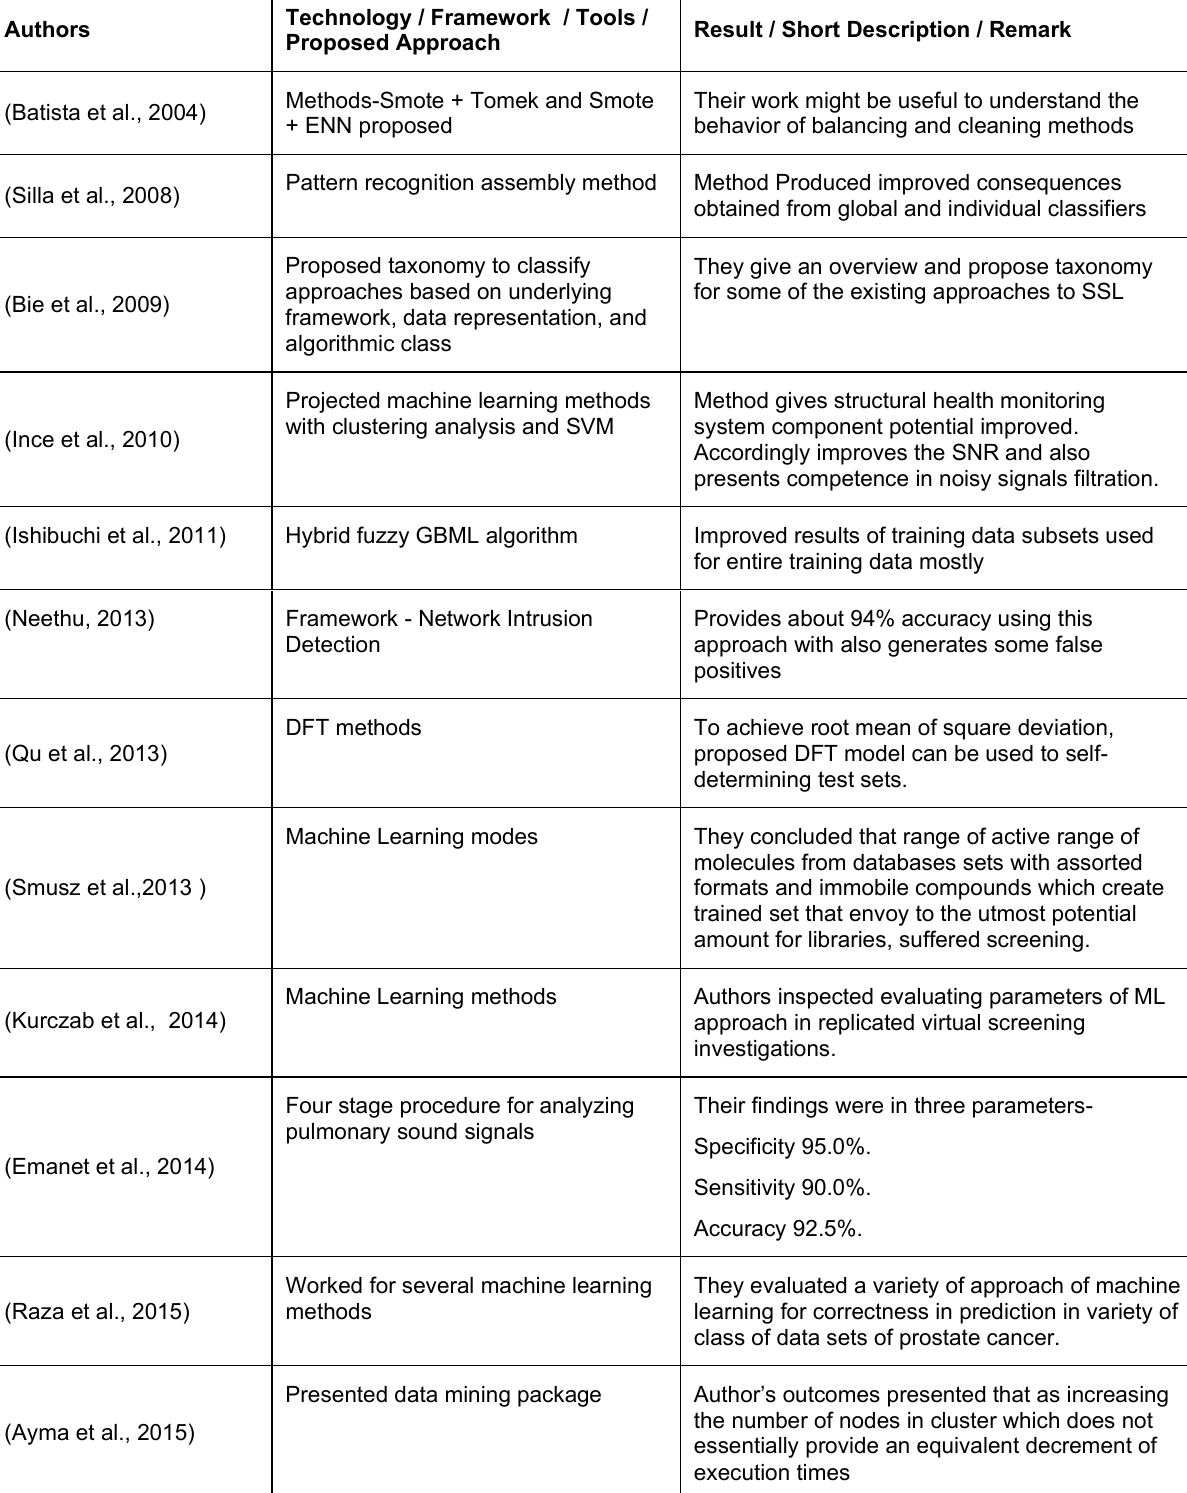
Table 1. Researcher / Author’s Various Targets with Satisfying Performance Matrices and Short